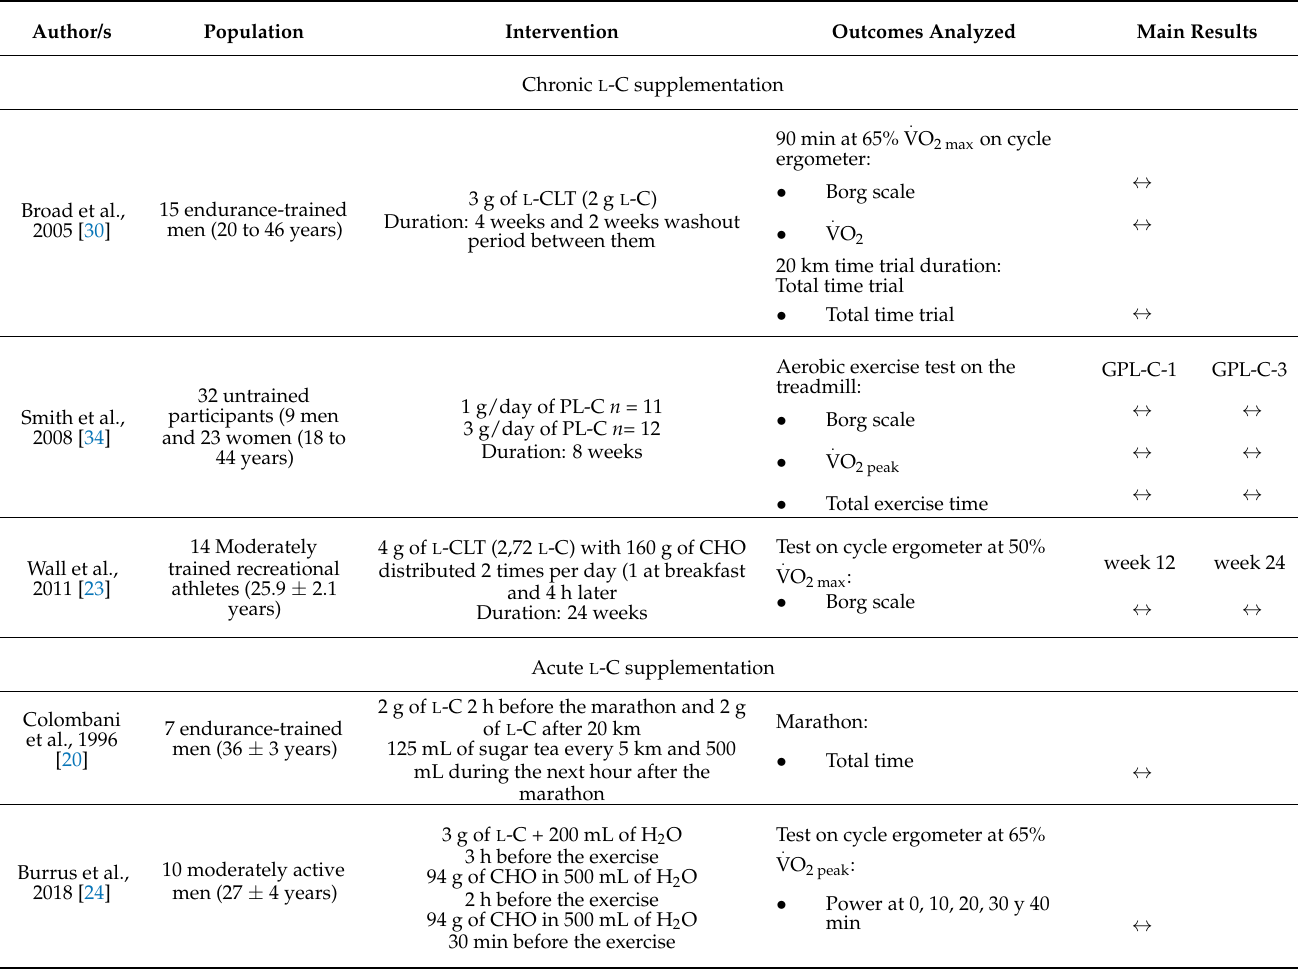
Table 4. Articles included in the systematic review that investigated the effect of L -Carnitine on low–moderate-intensity . (50–79% VO 2 max ) athletic performance